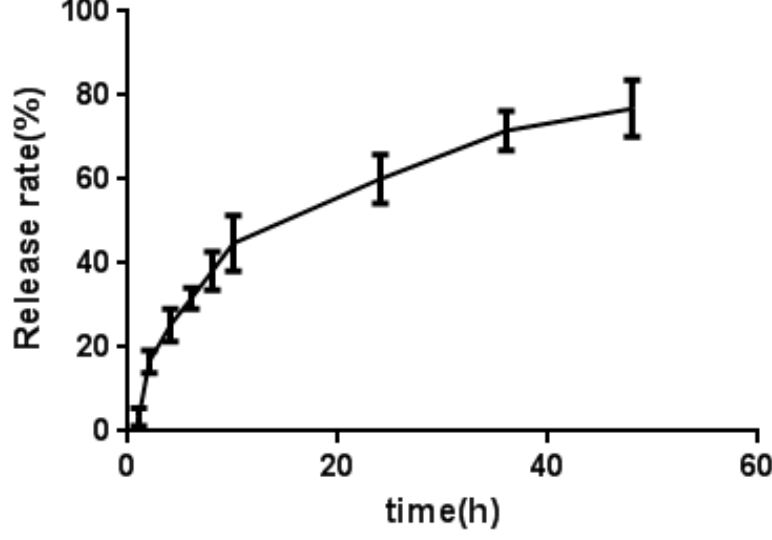
Figure 3. The release curve of mPEG-PLGA/AMDPC in PBS at 37 °C. Data are presented as mean ± standard error of experiments performed in triplicate.